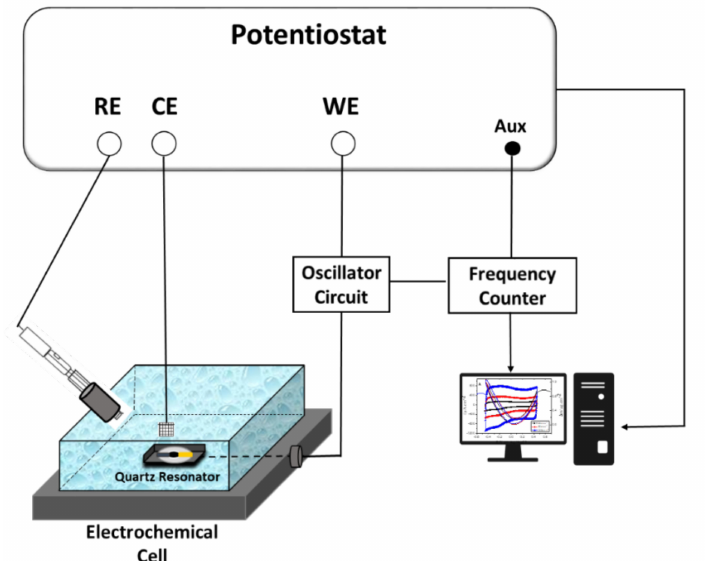
Figure 1. Experimental set-up of an